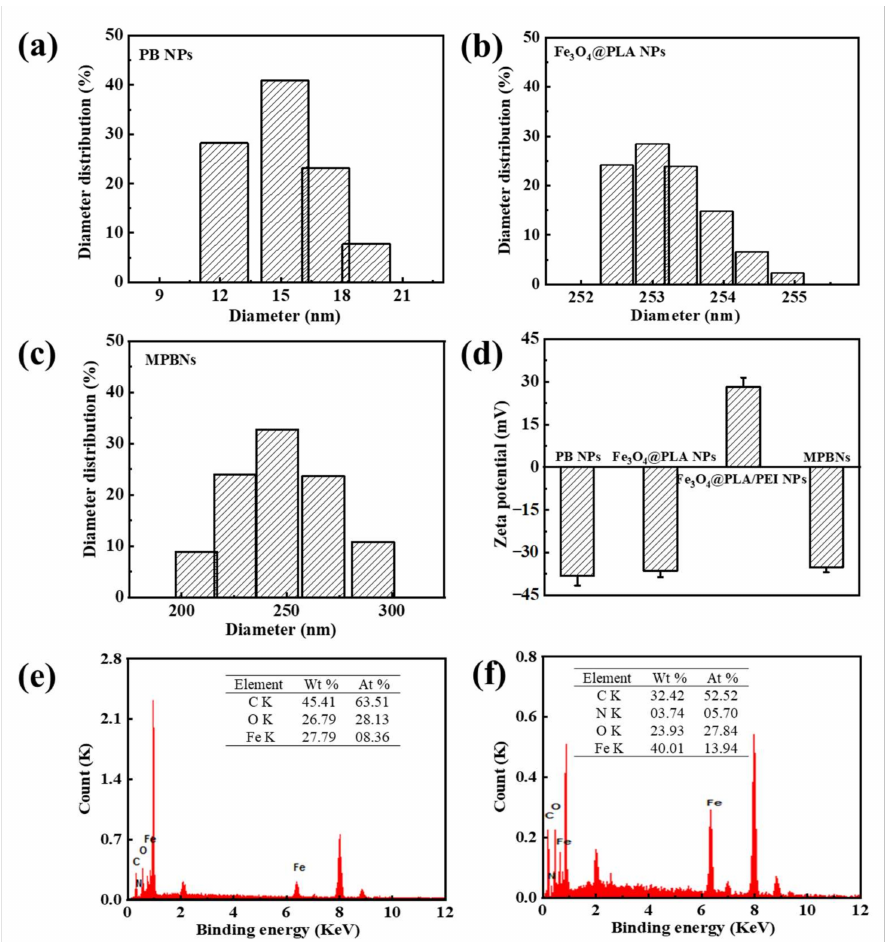
Figure 3. The size distribution of ( a ) PB NPs; ( b ) Fe 3 O 4 @PLA NPs; and ( c ) MPBNs. The zeta potential of the fabrication process of ( d ) MPBNs; EDS spectra of ( e ) Fe 3 O 4 @PLA NPs ( f ) and